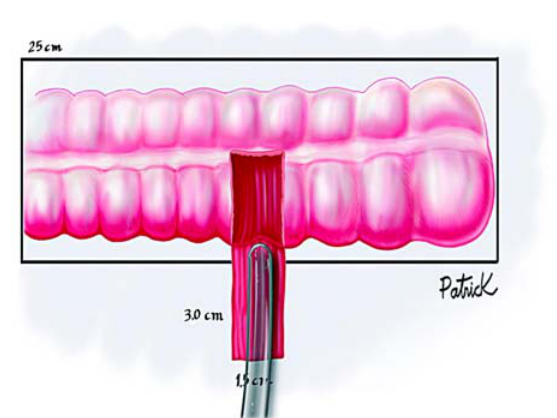
Figure 1 – 25 cm intestinal piece with overlapped mold.